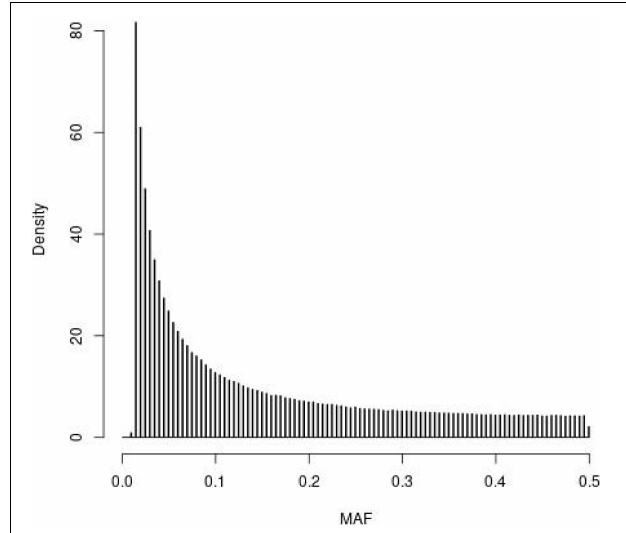
FIGURE 1 | Histogram of the minor allele frequencies (MAF) of the SNPs in the whole genome sequence of the founder population ( t = 0) observed in the simulations following 4000 generations of mutation and random